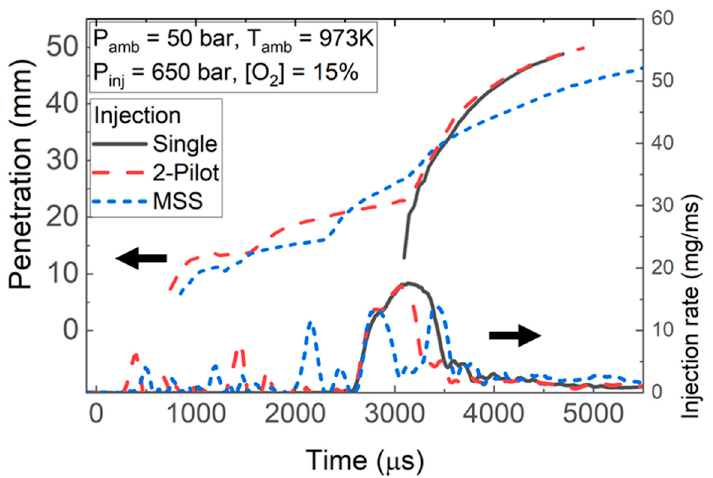
Figure 9. Flame penetration profiles of single, two-pilot, and MSS injection strategies.